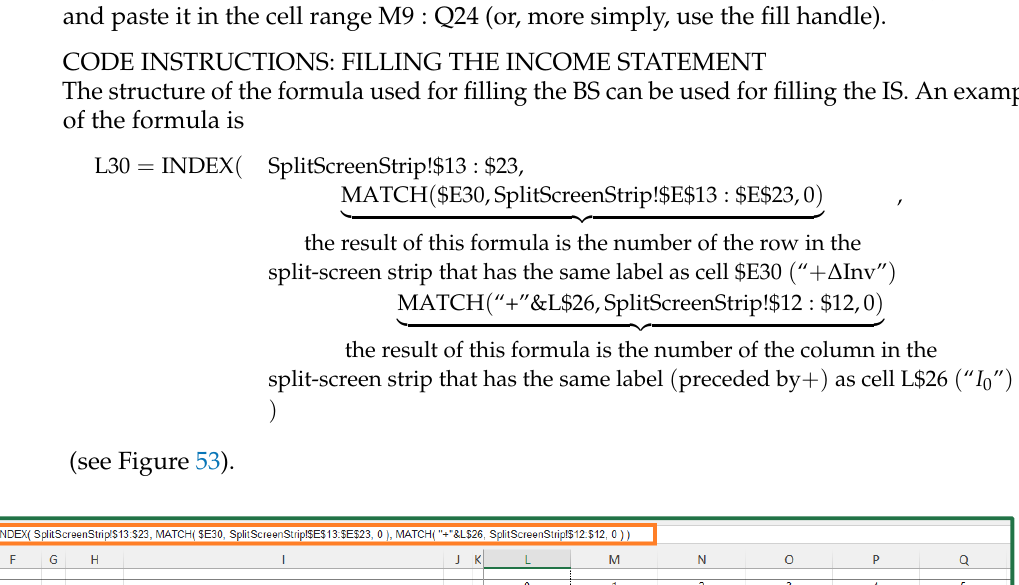
Figure 52. Cell L20 contains the formula fur summarizing 𝐶 (cid:3042) and 𝐶 (cid:3039) , which determine 𝐶 (cid:2919)(cid:2924)(cid:2932) (“ConventionalFinStat” sheet).